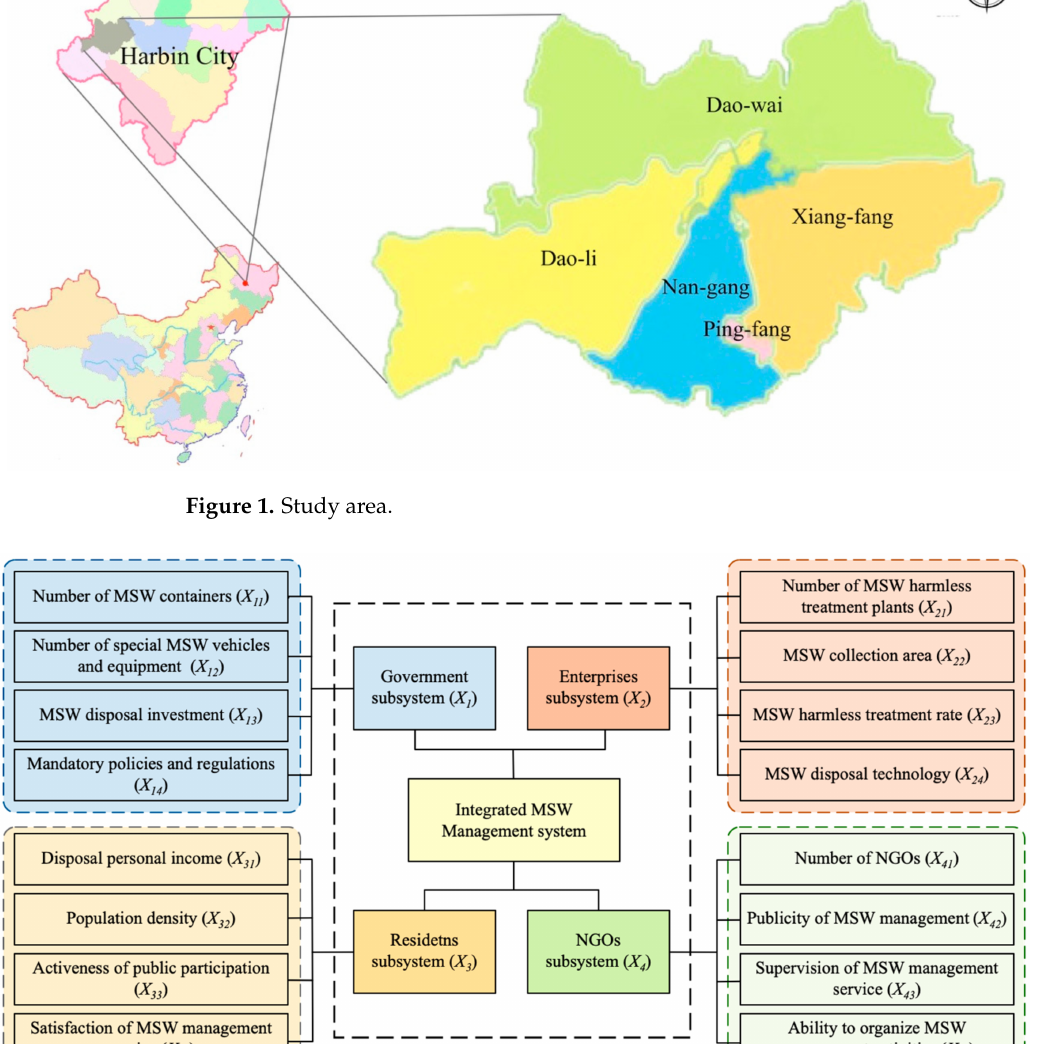
Figure 2. Stakeholder engagement evaluation indicators system in integrated MSW management.